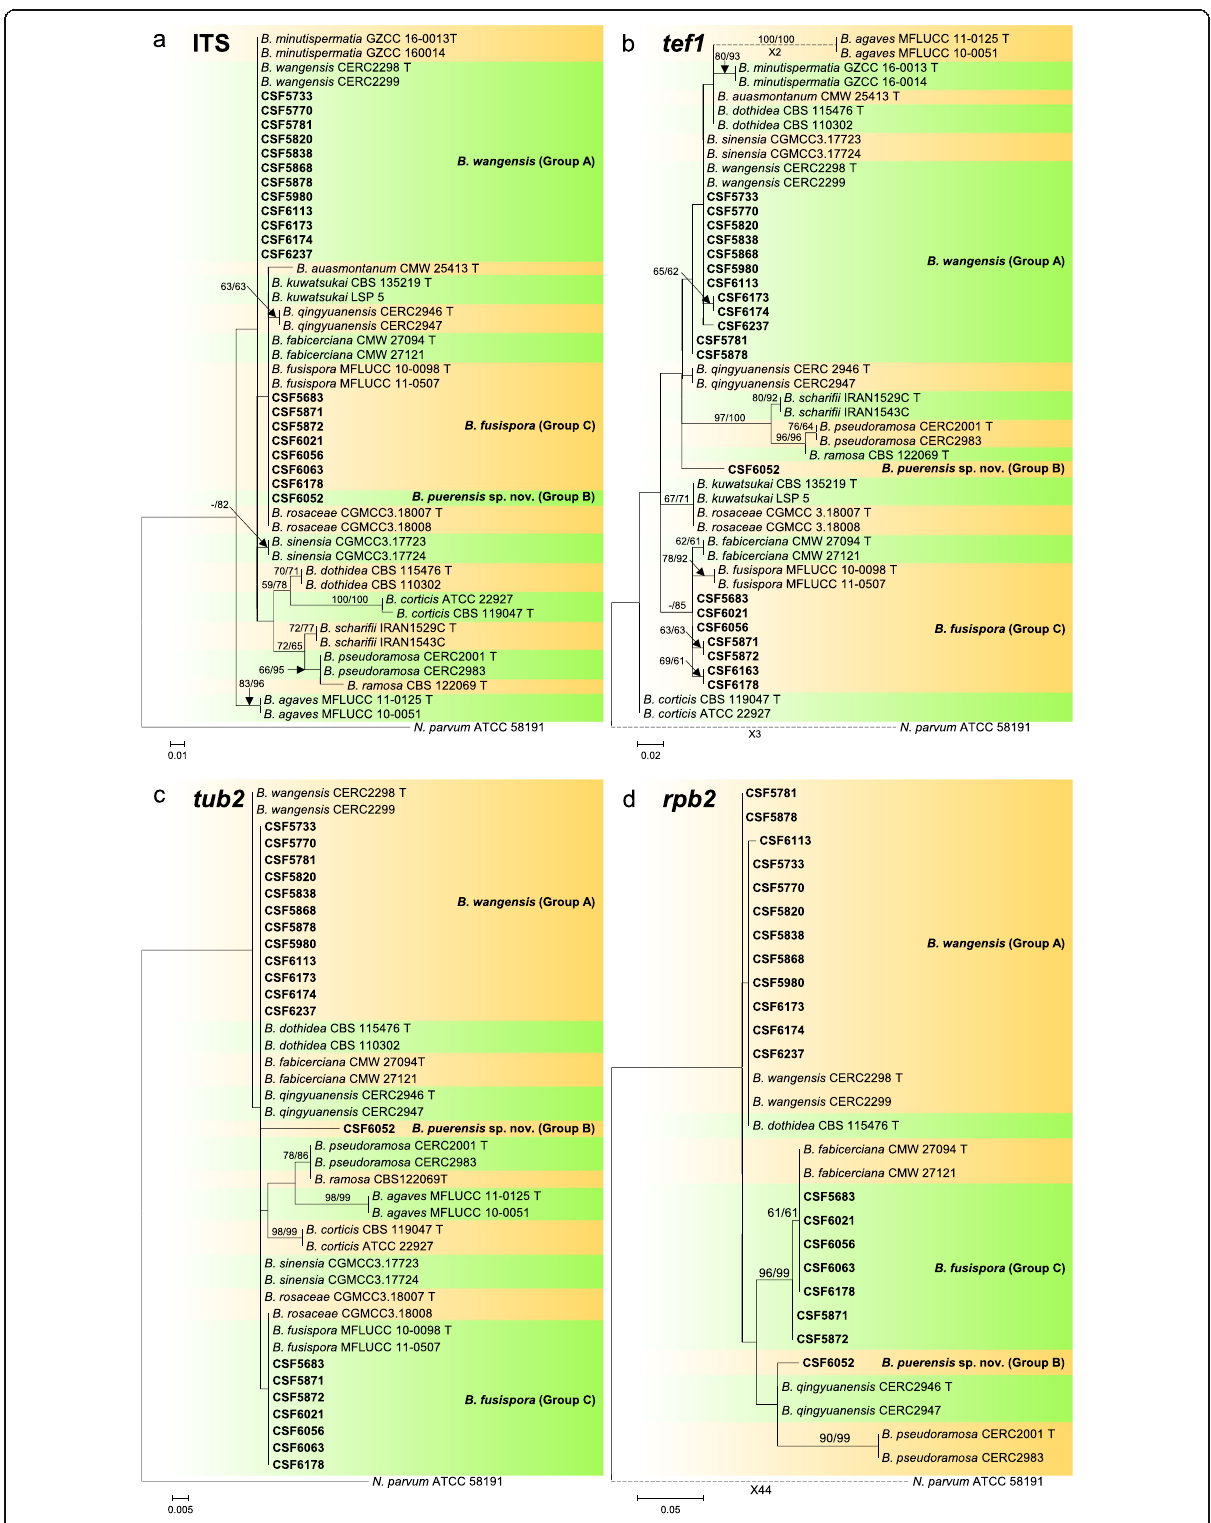
Fig. 2 Phylogenetic trees based on maximum likelihood (ML) analyses for species in Botryosphaeria . a . ITS; b . tef1 ; c . tub2 ; d . rpb2 ; e . combination of ITS, tef1 and tub2 . Isolates sequenced in this study are in bold. Bootstrap support values ≥ 60% for ML and MP are presented above branches as follows: ML/MP, bootstrap support values <60% are marked with ‘ - ’ , and absent are marked with ‘ * ’ . Ex-type isolates are marked with ‘ T ’ . The trees were rooted to N. parvum (ATCC